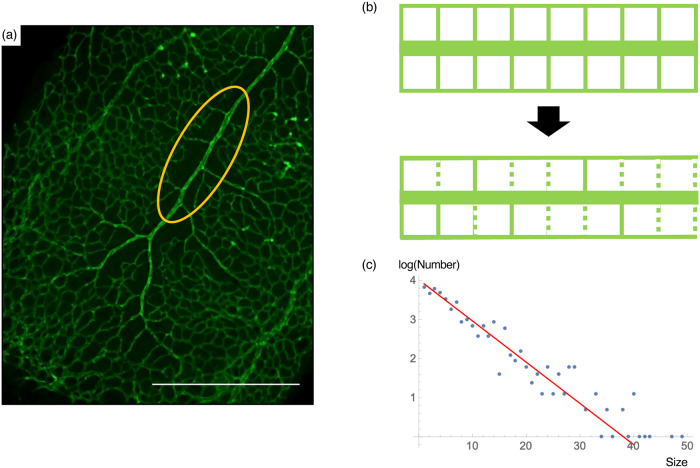
A model of large islands formation in the endothelial network.(a) Large islands in the endothelial network are mainly avascular zones around the arterial tree. This region is generated by the retardation of capillaries in the high oxygen concentration region around the arteries [2]. (b) A minimal model of island formation. At first, the vascular meshwork around an artery is a regular rectangular configuration. As blood flow is established, some of the capillaries adjacent to the arteries disappear by a probability p, resulting in larger islands of specific size distribution. (c) Numerical simulation of the above model (blue dots) generated size distribution that showed linearity in log–linear plot, consistent with the analytical prediction (red line. gradient = log p). Scale bar = 500 μm.